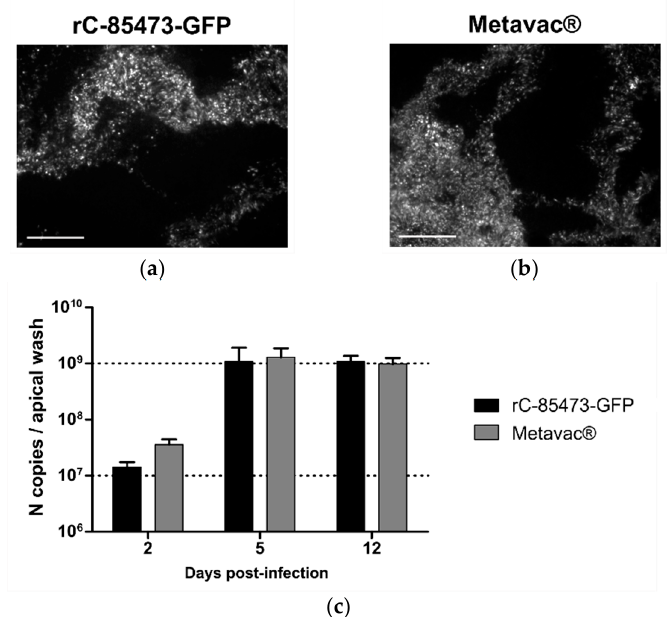
Figure 5. Recombinant HMPVs produced in the DuckCelt ® -T17 cell line conserved infectivity and replicative capacity in 3D-reconstituted human airway epithelium (HAE). MucilAir™ epithelia from healthy donors infected with rC-85473-GFP or Metavac ® viruses produced in DuckCelt ® -T17 cells at an MOI of 0.1 and monitored for 12 days. Viral spread of ( a ) rC-85473-GFP T17 or ( b ) Metavac ® T17 in HAE at 5 dpi observed by fluorescence microscopy (10× magnification, scale bars represent 250 µm). Viral quantification from ( c ) epithelium apical washes at 2, 5, and 12 dpi performed by specific RT-qPCR of the N viral gene. Data shown as means ± SD and represent experimental duplicates.